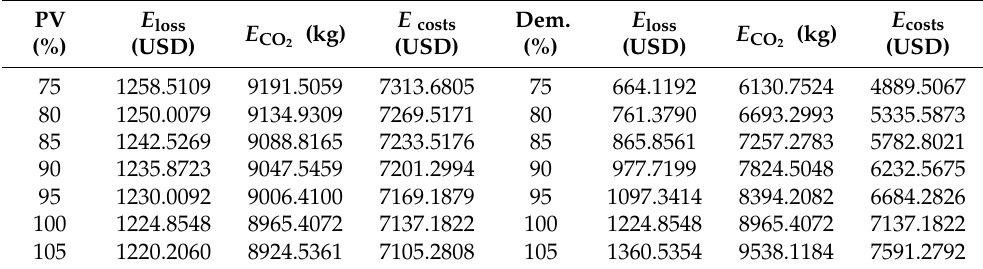
Table 4. Sensitivity analysis regarding variations in the power generation availability and demand behavior (all values are per day of